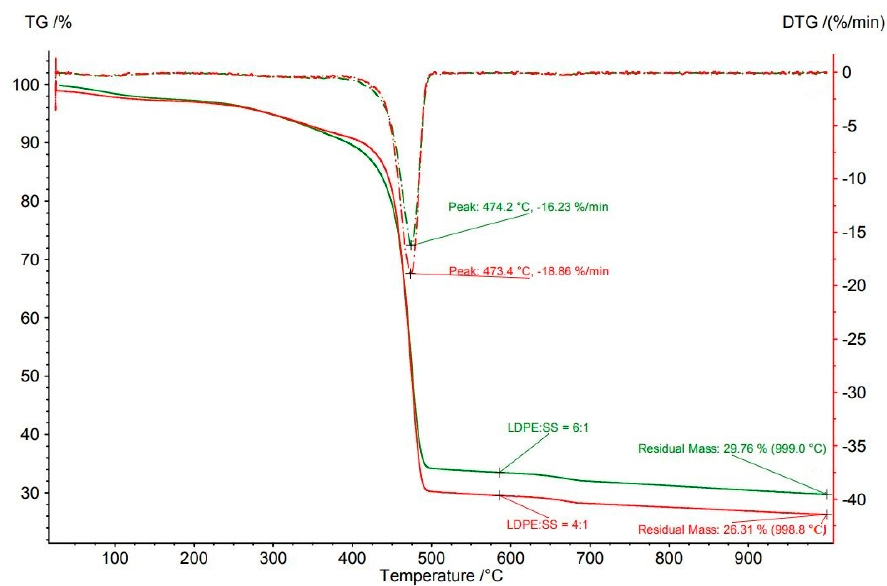
Figure 9. TG/DTG curves of LDPE:SS in 2 different volume ratios.